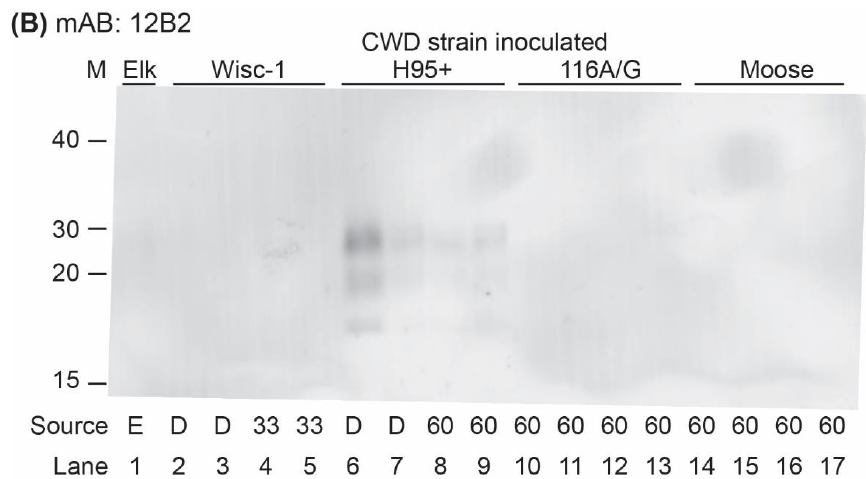
Figure 3. TgBeaver-adapted CWD prions. TgBeaver mice were inoculated with CWD prions from Elk (lane 1; E), white-tailed deer (lanes 2, 3, 6, 7; D), tg33 96G cervidized mice (lanes 4, 5; 33), or tg60 96S cervidized mice (all other lanes; 60). The 10% brain homogenates were digested with 50 μg/mL of PK and analyzed by Western blotting. ( A ) The monoclonal antibody Bar224 (1:12,500) was used to detect beaver prions. ( B ) The N-terminal binding antibody 12B2 (1:3333) only recognizes the beaver-adapted H95+ CWD prions. Biology 2022 , 11 , 667